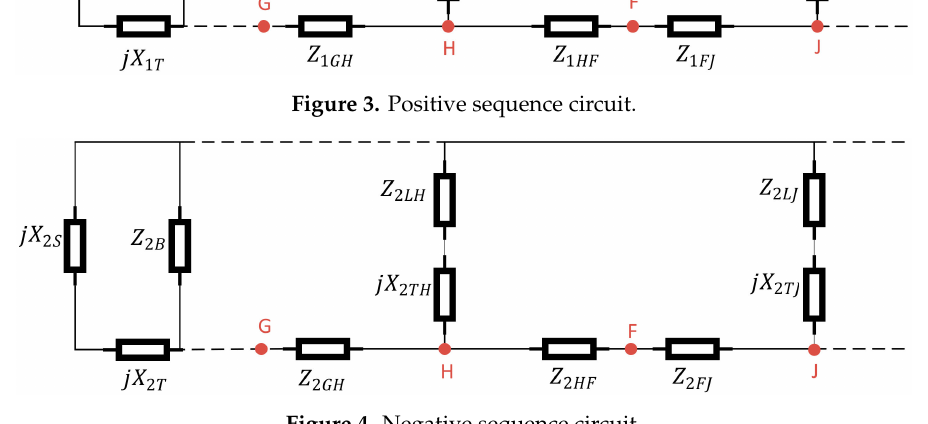
Figure 4. Negative sequence circuit.